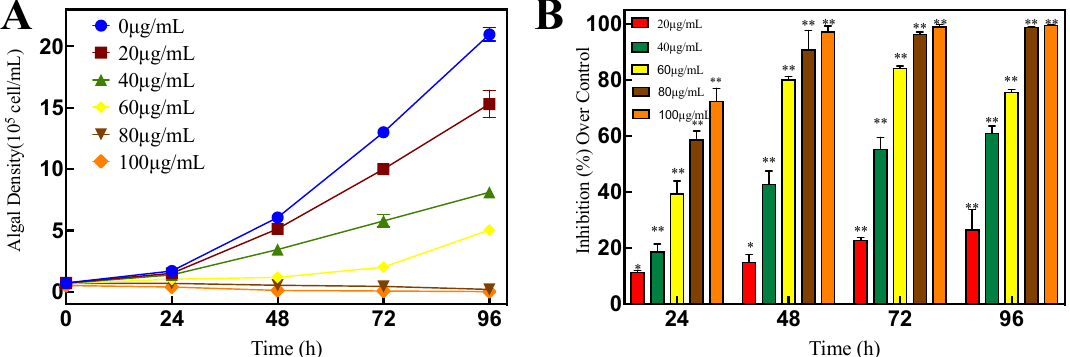
Figure 5. Effects of luteolin-7-O-glucuronide on the algal density of P. globosa ( A ) growth curve; ( B ) inhibition rate. Data are means ± SD (n = 3). * p < 0.05, ** p < 0.01 indicate significant differences. Table 2. Summary of the peak area of flavonoids from E. acoroides aqueous extracts.